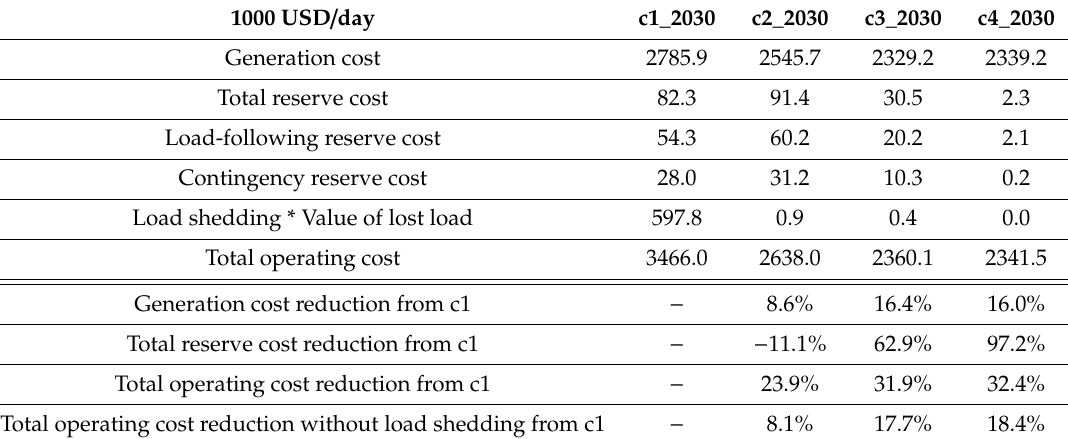
Table 7. Daily operating costs of generation and reserve for a summer peak day in